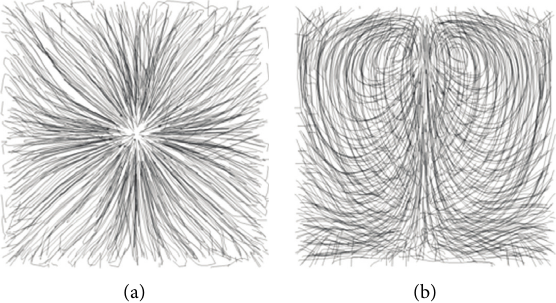
Figure 6: Streamline distribution of velocity field in different views: (a) top view of x - y axis and (b) left view of y - z axis. Time=60 d